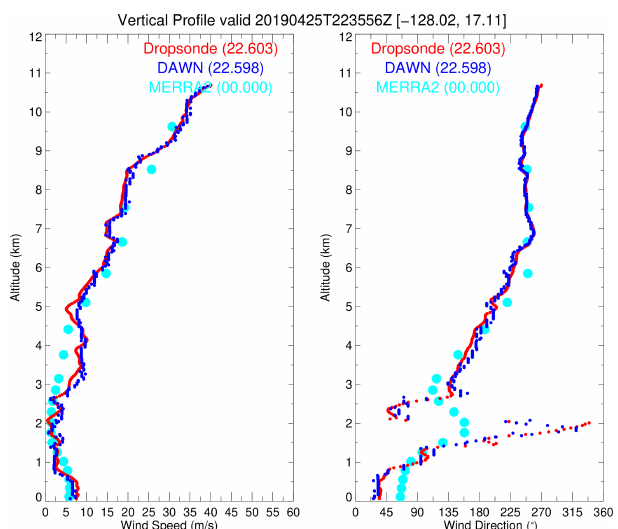
Figure 11. Dropsonde (red), DAWN (blue), and MERRA-2 (cyan) for DAWN profiles at 2235UTC, on 25 April 2019, in an air mass with weak aerosol signal within the 2–6km altitude layer when DAWN was operating in 2 azimuths, 200pulse per azimuth